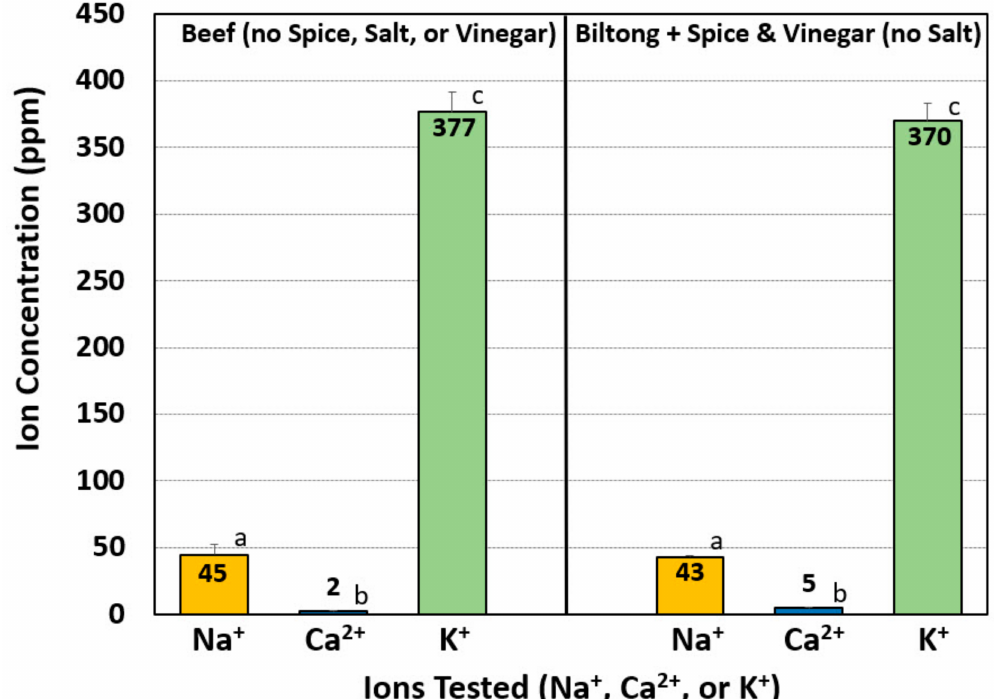
Figure 5. Comparison of ion concentrations of biltong made with dried beef without spice, salt, or vinegar and biltong made with only spice and vinegar marinade (without salt). Data are presented as the mean of triplicate replications, and error bars represent the standard deviation from the mean. Comparisons of means with di ff erent letters are significantly di ff erent ( p < 0.05) as determined by one-way ANOVA using the Holm–Sidak test for pairwise multiple comparisons; means with the same letter are not significantly di ff erent ( p > 0.05).